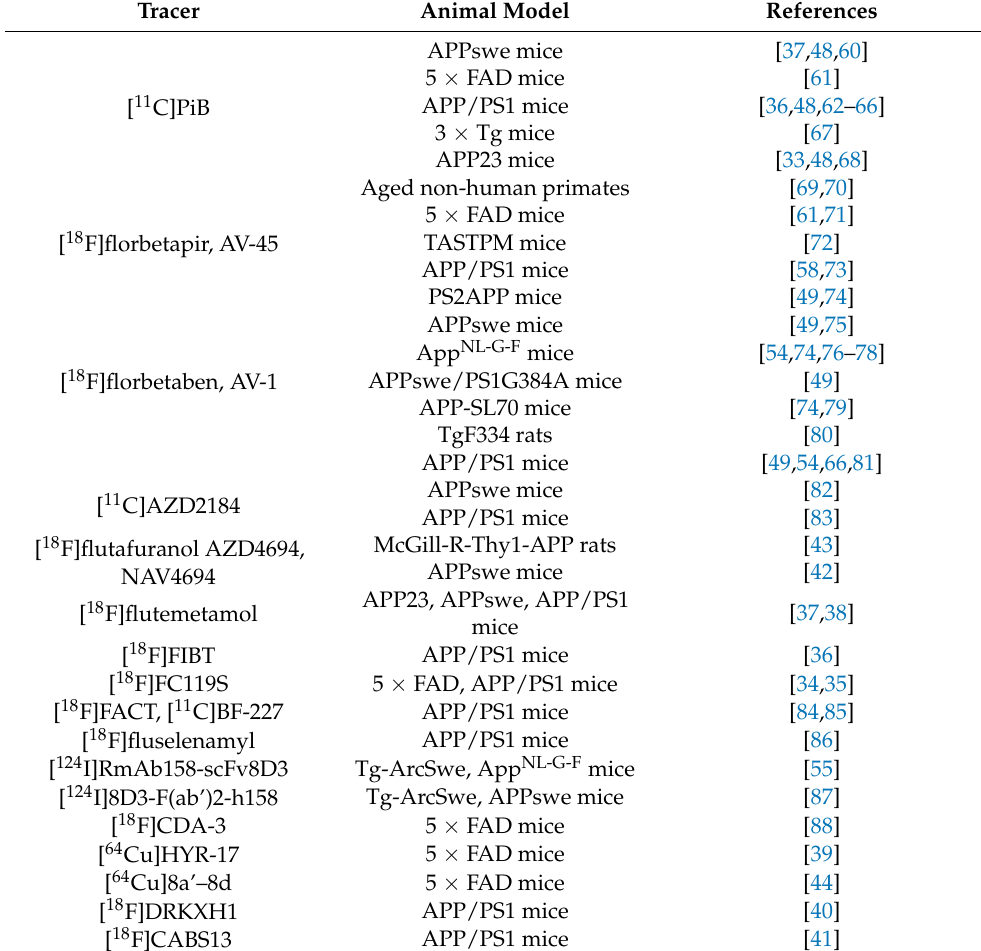
Table 1. Amyloid-beta PET imaging in animal models of Alzheimer’s disease amyloidosis.